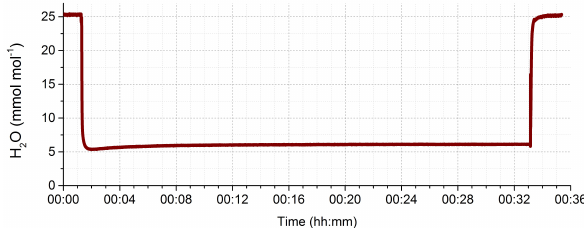
Fig. 4. The water vapor signal measured with the LI-7000 hygrom- eter before, during, and after switching the Nafion dryer into the sample flow